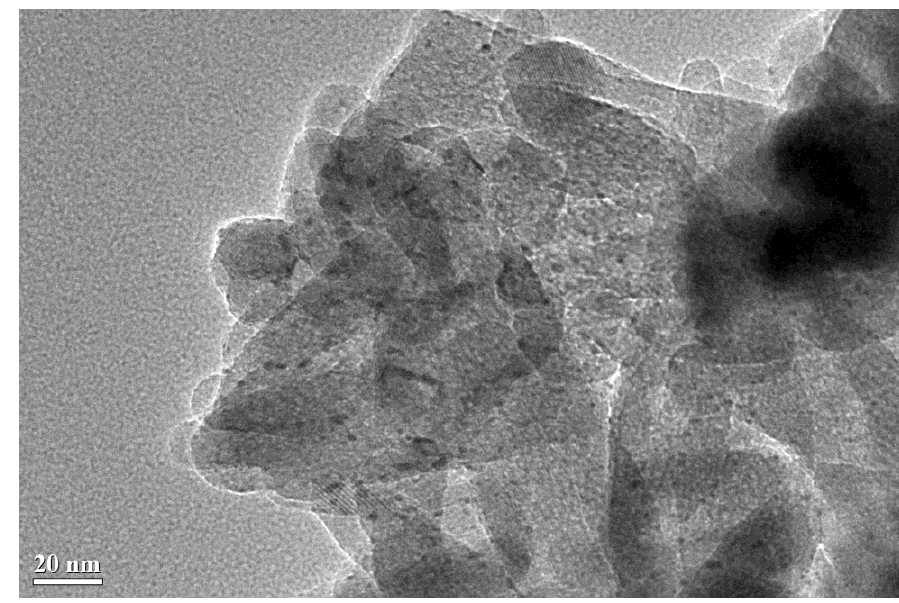
Figure 5. TEM image of spent Pt/Ca-P-O (calcined at 500 °C, pretreated in 4% H 2 at 300 °C, and tested in CO